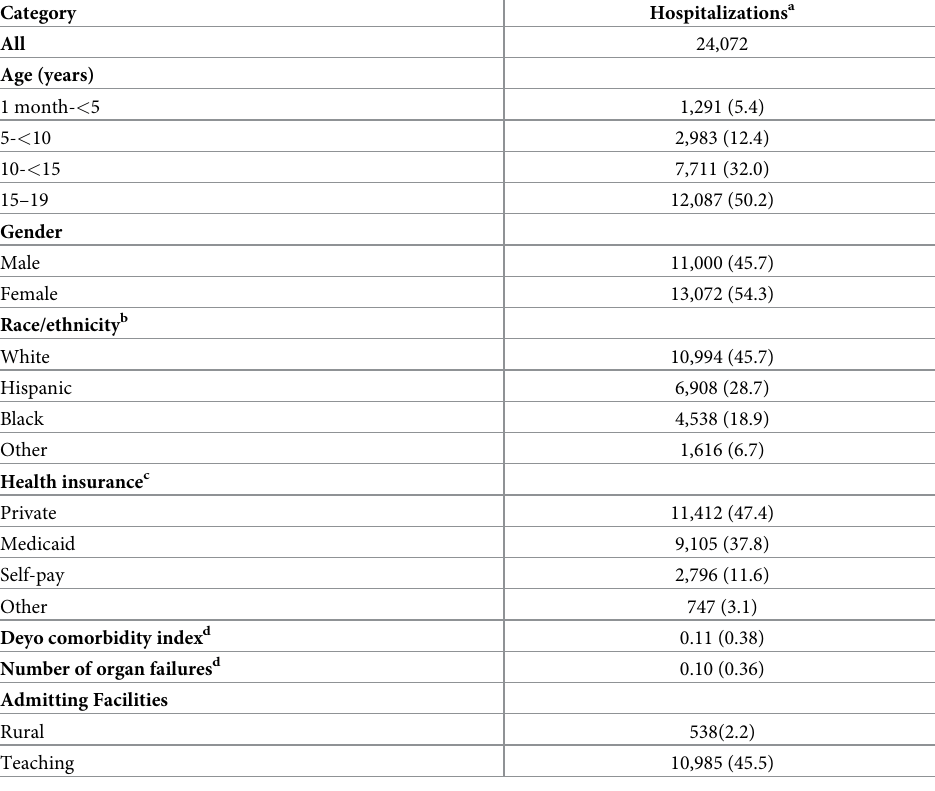
Table 1. The characteristics of hospitalizations with diabetic ketoacidosis in Texas, 2005–2014.